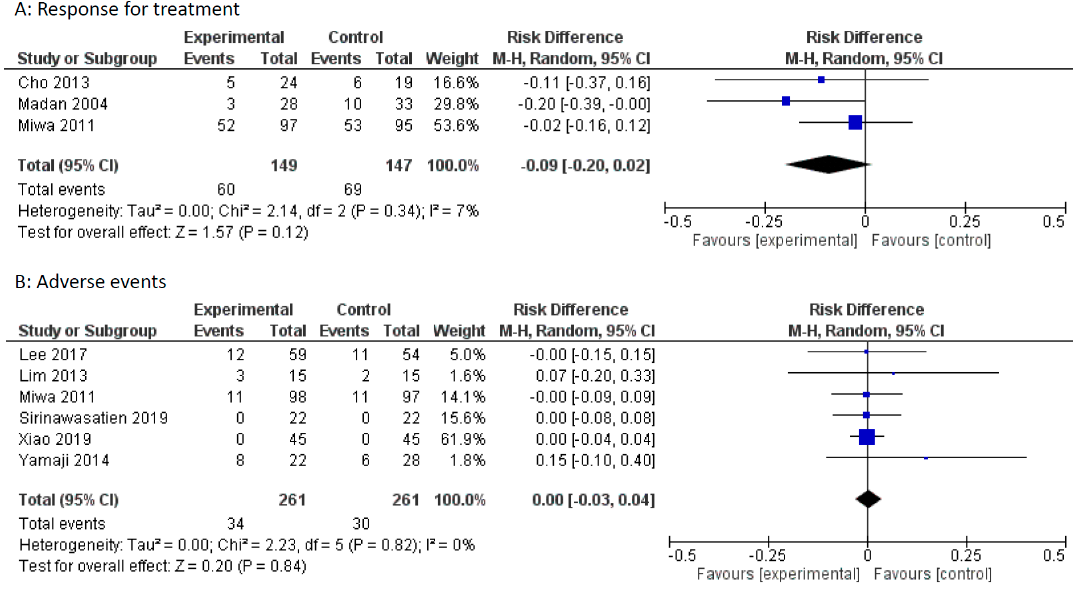
Figure 3. Funnel plot of the included RCTs for symptom score after treatment.